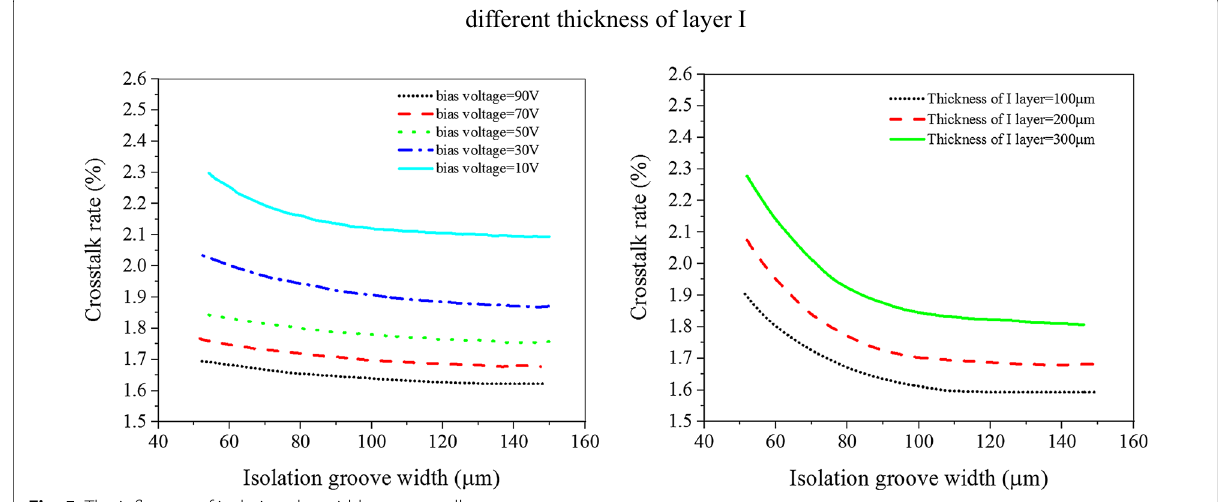
Fig. 5 The influence of isolation slot width on crosstalk rate